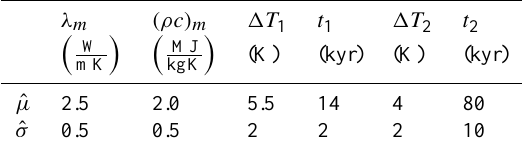
Table A1. Parameters used for the Monte-Carlo simulations in this study. They were assumed to be independently and normally dis- tributed. λ m and (ρc) m are the rock matrix